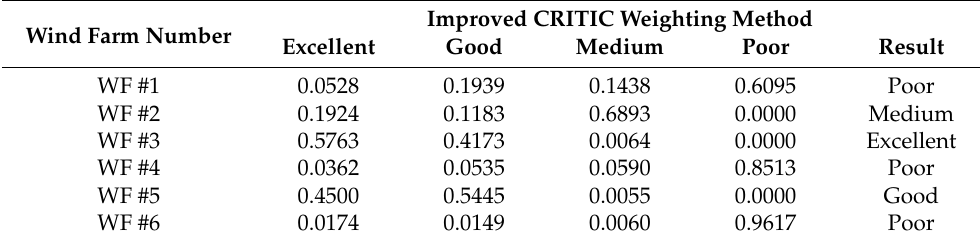
Table 11. The comprehensive evaluation results of wind farms power generation performance (improved CRITIC weighting